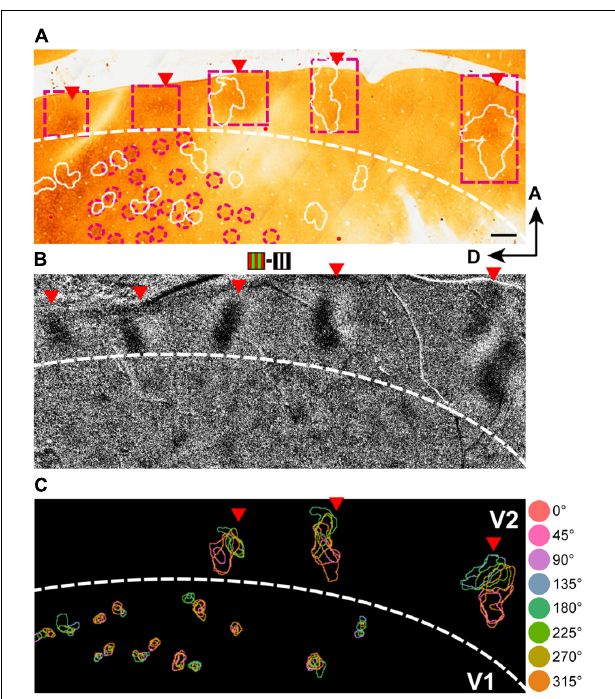
FIGURE 5 | The organization of hue clusters in V1, V2, and V4. (A) A scanned image of a CO-stained tangential section from the imaged region in the V1 and V2 of case 2. The Section was cut mainly through the supragranular layer. The white contours indicate hue clusters in V1 and V2 in the imaged region (shown in B ) that were aligned with the section with the aid of radially penetrating vessels. The magenta dashed frames indicate the locations of thin stripes in V2. The magenta dashed circles indicate the location of CO blobs close to hue clusters in V1. Scale bar, 500 µ m. (B) A subtraction map in response to red/green minus black/white grating stimuli in the same cortical region as in (A) . Red triangles indicate patchy responsive regions in V2 in that map. For reference, the corresponding locations in (A) are also indicated by red triangles. (C) A map of hue domains in the same field of view as in (B) . The color contours indicate the locations of hue domains in individual hue clusters.